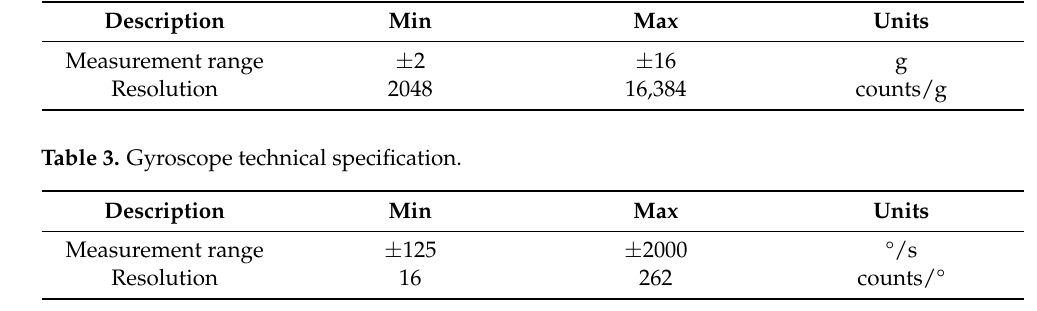
Table 2. Accelerometer technical specification.